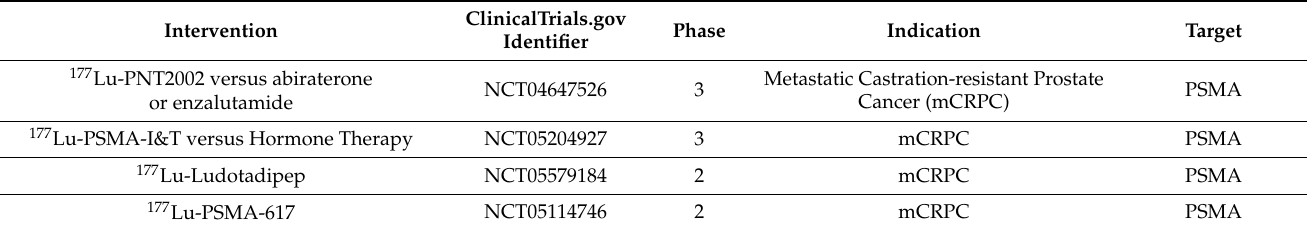
Table 1. Current clinical applications and trials of Lutetium-177 ( 177